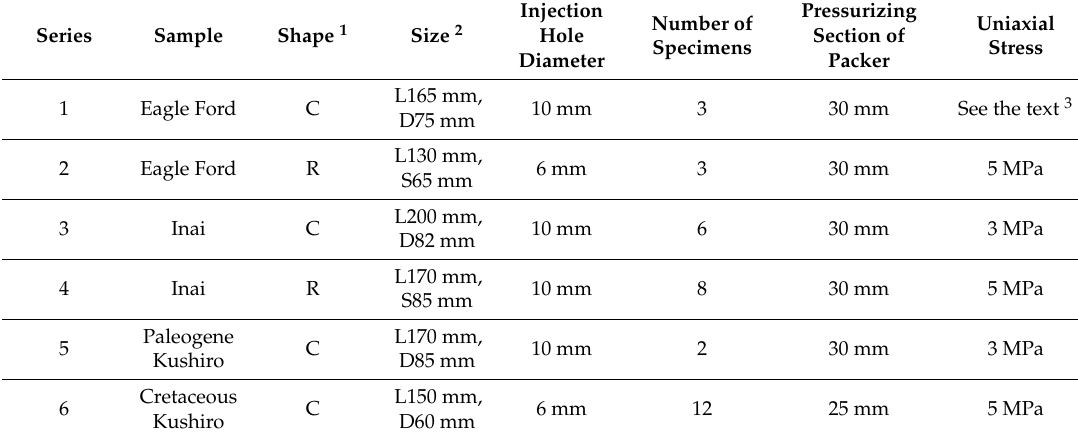
Table 1. Specimen sizes and experimental conditions.